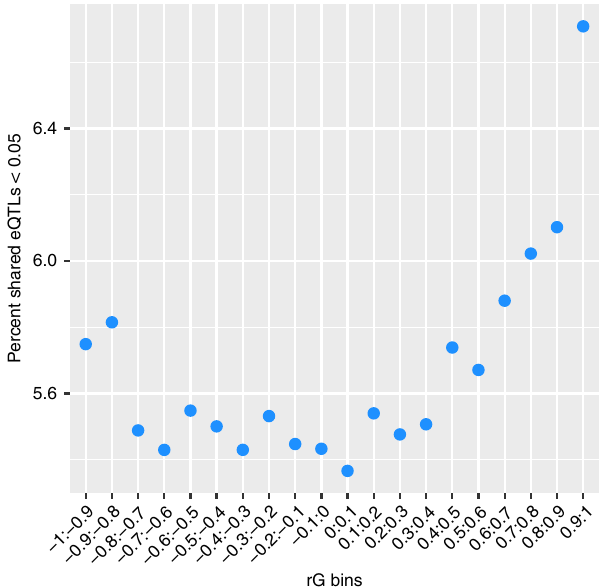
Fig. 3 The percentage of genetically correlated trans transcript pairs with signi fi cant, independent, shared eSNPs in ^ r G bins of size 0.1. A modest enrichment of shared eQTLs, between 0.4 – 1.0, is evident for transcript pairs with a positive ^ r G , with a spike between 0.9 – 1.0 indicating more shared eSNPs in fl uence each other in a positive allelic